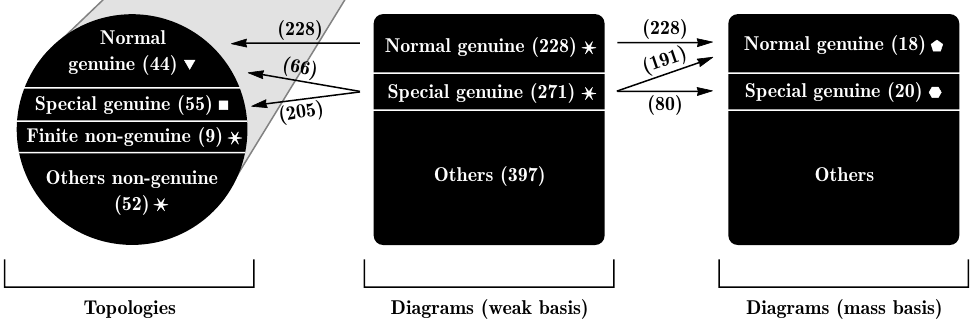
Figure 5 . Corrected counting for topologies and